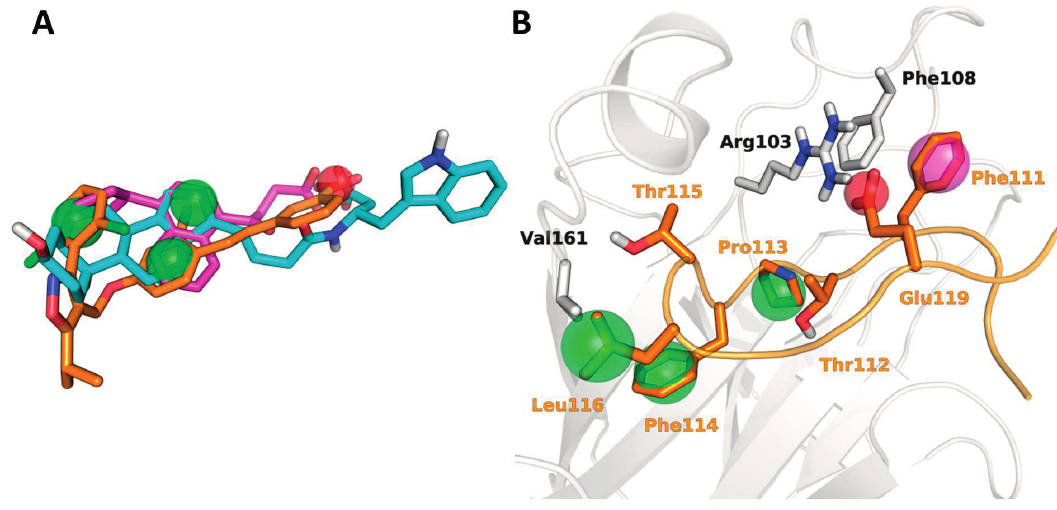
Figure 7. Pharmacophore models employed for VS. Pharmacophore sites are represented as spheres: hydrophobic (green), negatively charged (red), aromatic (magenta). ( A ) Model I superposed on the aligned structures of compounds 7 (cyan carbons), 8 (orange carbons), 10 (magenta carbons); ( B ) Model II represented on the crystallized conformation of the G-H loop of ephrin-A1 (orange carbons) within the structure of EphA2 (white cartoons and